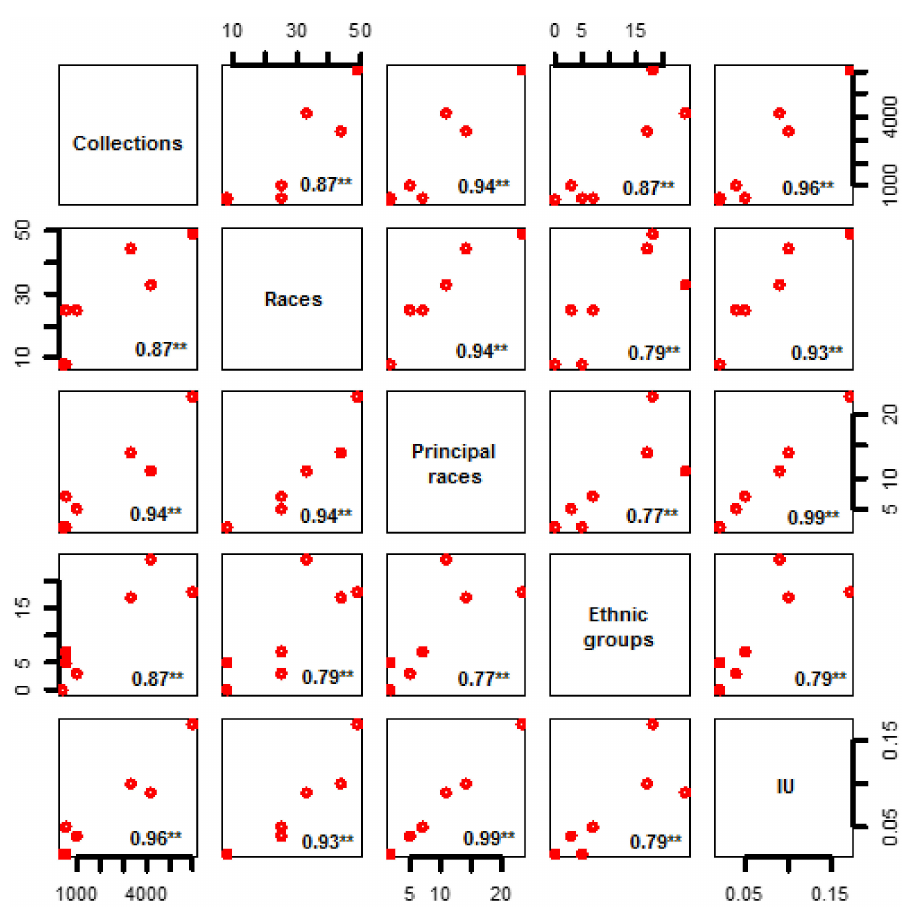
Figure 6. Scatterplot matrix of Pearson’s correlation coefficient that associates the presence of ethnic groups in the environmental units with the number of collections, number of races, number of principal races, and index of maize uses (grain and plant) (n = 7). ** p <